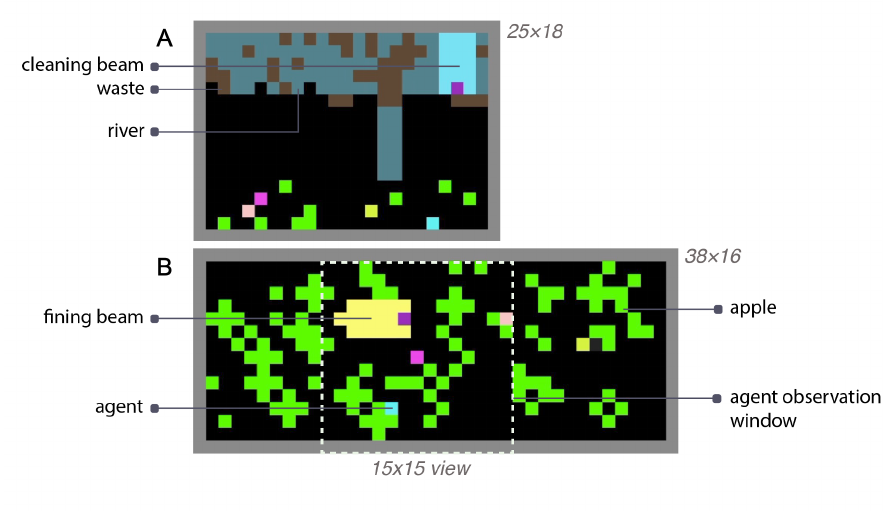
Figure 2. ( A ) Cleanup game. ( B ) Harvest game. Agents obtain rewards by collecting apples which is the green grid. Agents can fine each other through punishment